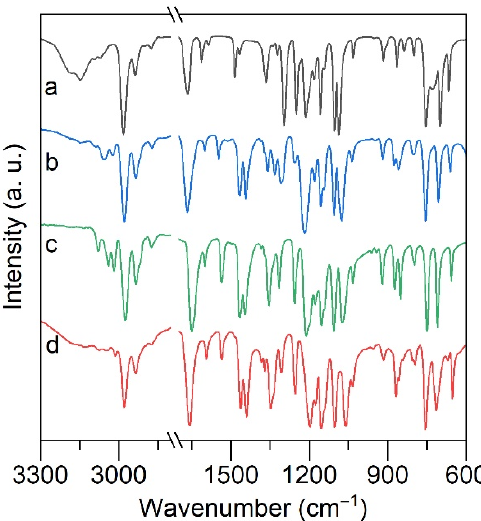
Figure 2. FT-IR spectra: a—isopropyl salicylate (HL), b—LiL, c—NaL, d—KL.